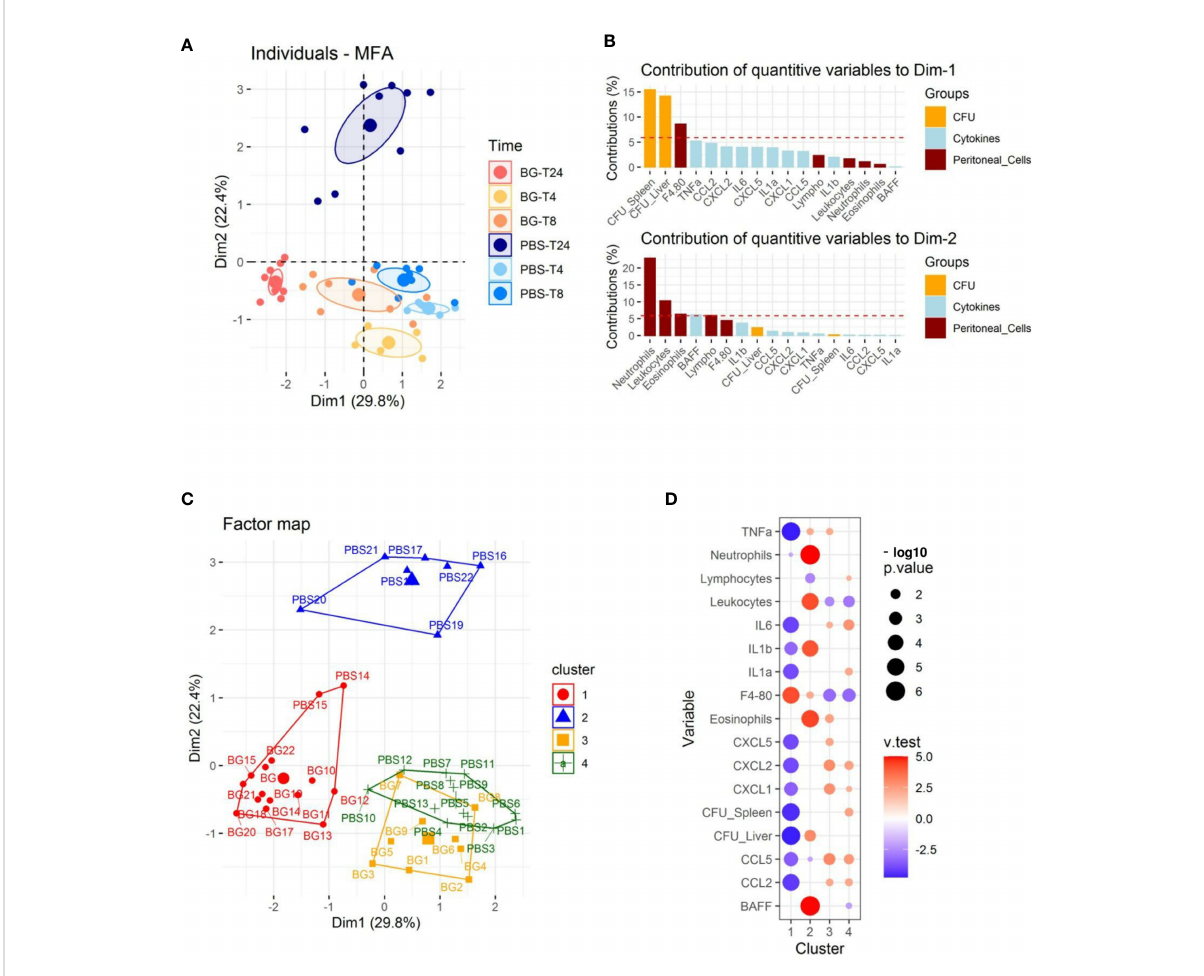
FIGURE 2 Multifactorial analysis and hierarchical clustering of immune and bacteriological parameters recorded from individual mice sampled at 4, 8, and 24 h p.i. (A) Individual factor map. (B) Respective contribution of quantitative variables to dimensions 1 and 2. (C) Cluster plot from hierarchical clustering performed according to Ward ’ s Method. (D) Bubble plot indicating variables positively (red) or negatively (blue) characterizing clusters according to the test value (v-Test). Bubble sizes re fl ect the statistical signi fi cance (-log10 p value). The number of mice used and experiments are detailed in Supplementary Table